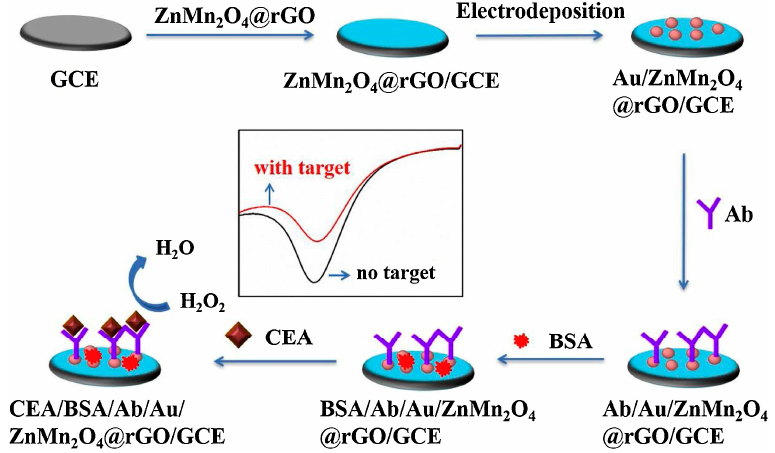
Figure 11. The schematic diagram of the amperometric immunosensor preparation [98]. Copyright (2021) Elsevier.